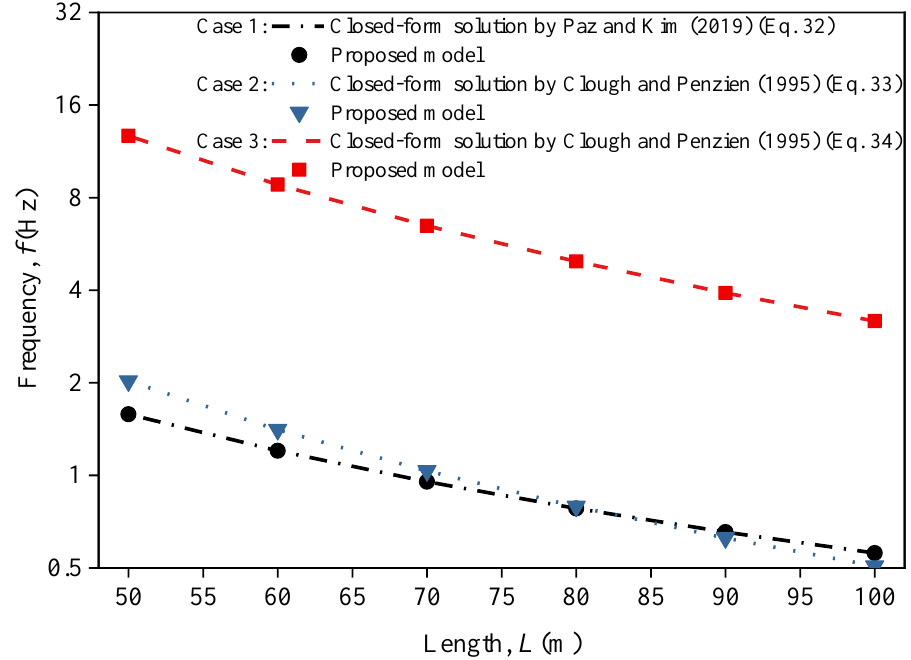
Figure 6. Natural frequency against tower length in different cases [39,45].